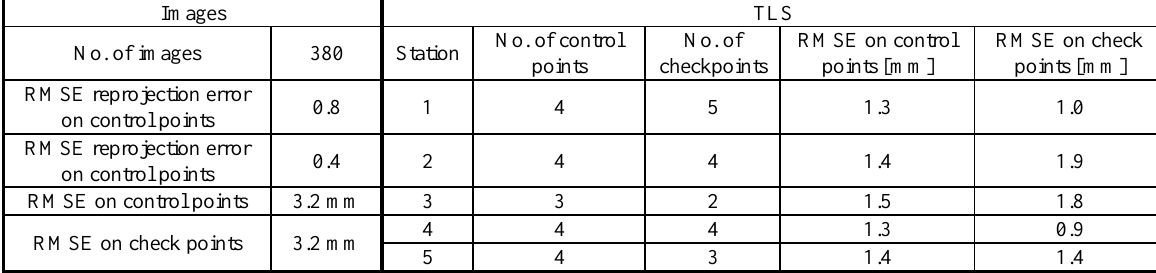
Table 1. The results of the processing of TLS data and photographs with the Structure-from-Motion method